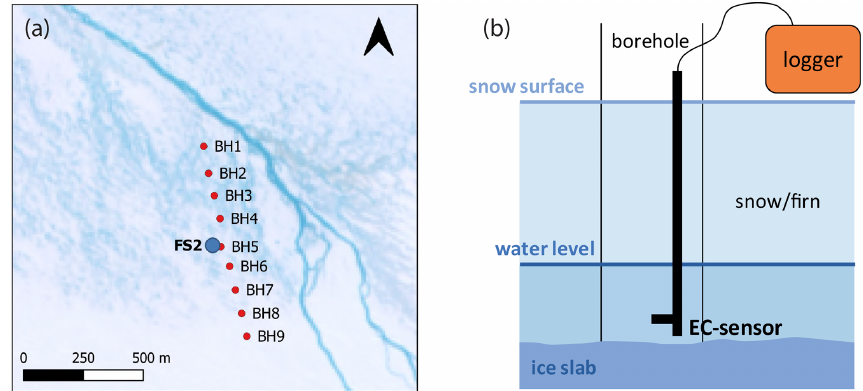
Figure 8. (a) Location of boreholes (red points) on the GrIS during the summer 2020 field campaign. The background image is a Sentinel 2 true colour composite from 12 August 2019, around the time of maximum melt extent that year. (b) Schematic representation of the measurement set-up during salt dilution experiments.